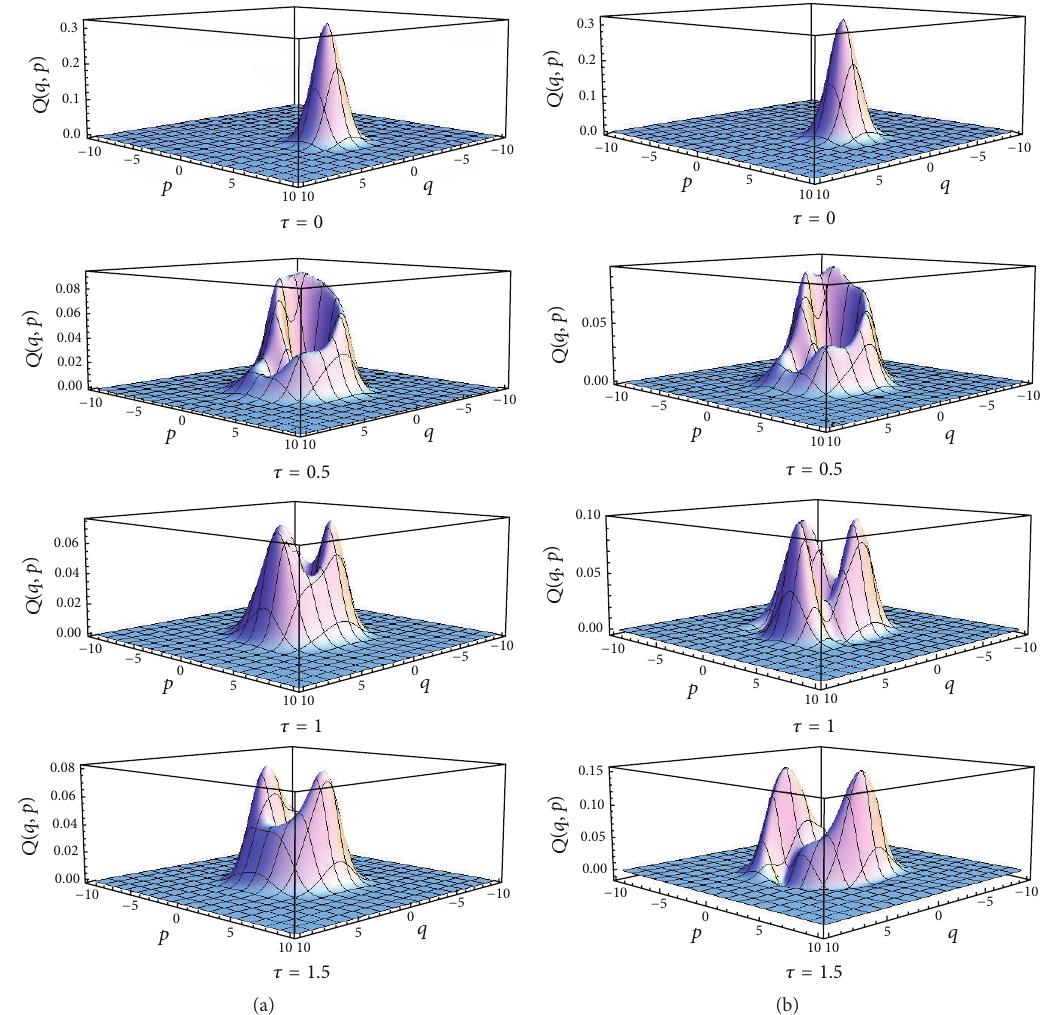
Figure 2: Evolution of the 𝑄 -function with 𝛼 = 2 and 𝜆 = 0.13 . (a) Exact solution and (b) approximated solution.